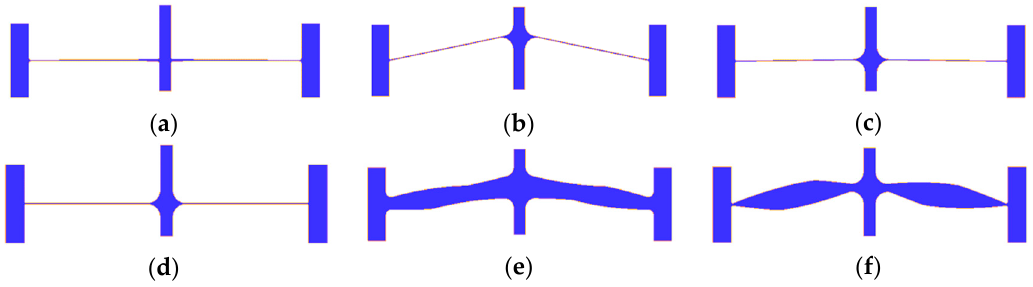
− 1678.99 Table 3. Results of the optimization—values of the design variables.